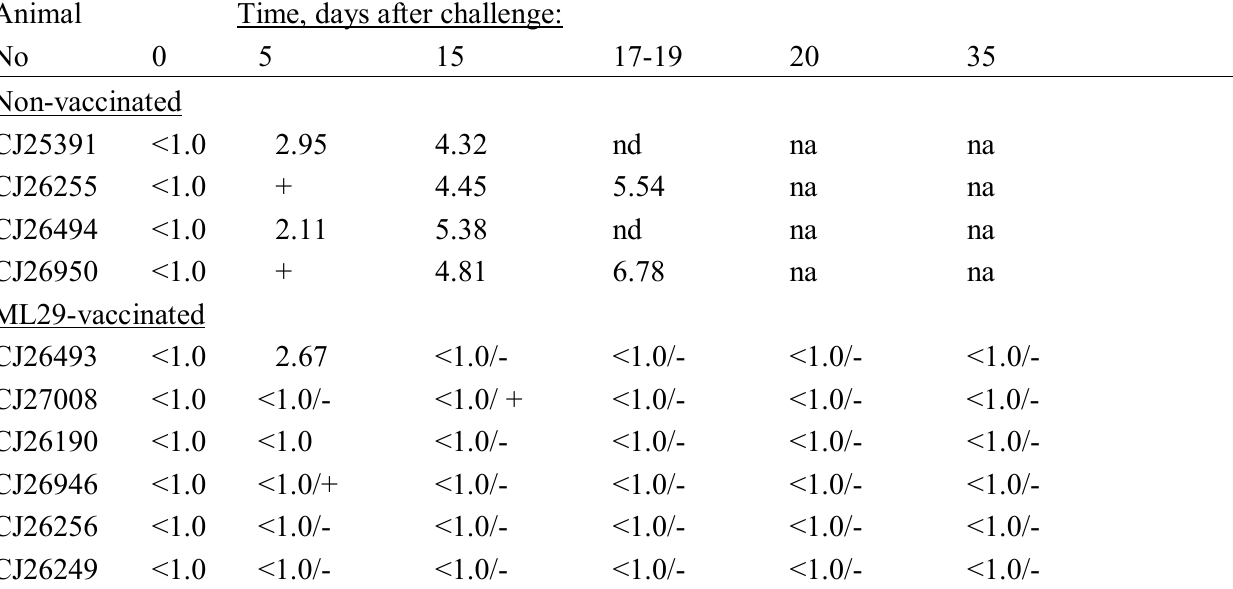
Table 3. Viremia in marmosets vaccinated with ML29 and challenged on day 30 with LASV a